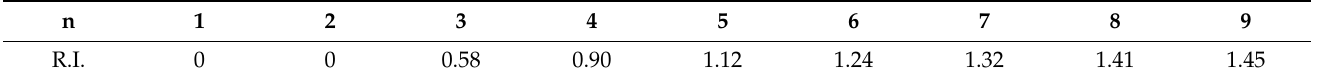
Table 10. The values of R.I. in list of